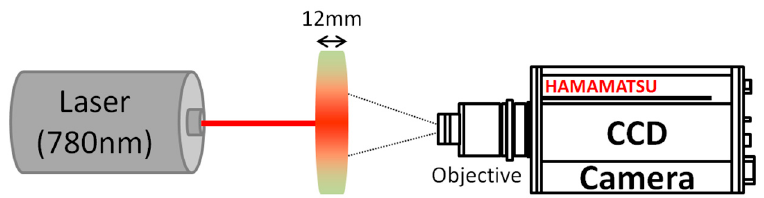
Figure 1. Schematic view of the speckle experimental setup. A 780 nm laser beam illuminates an apple slice. Scattering spot images are acquired using a CCD equipped with an